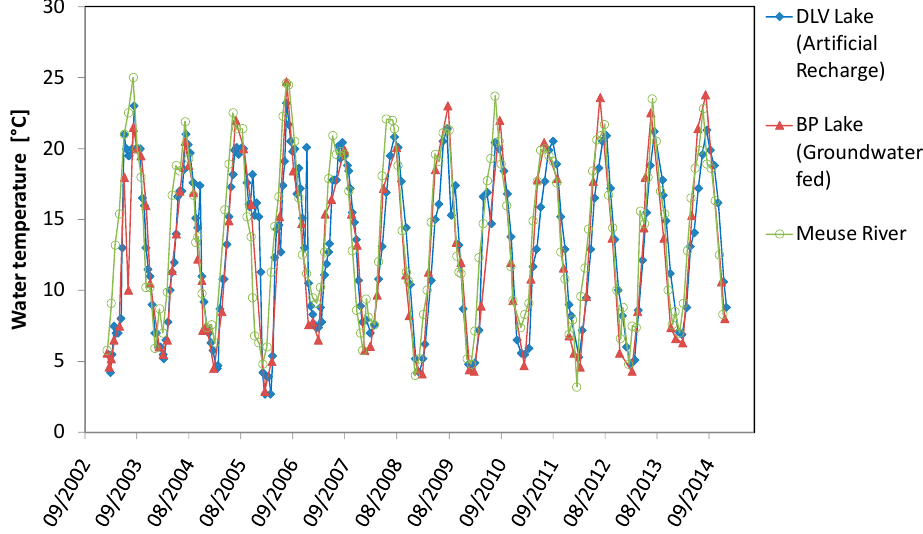
Figure 6. Temperature of gravel pit lake with artificial recharge (DLV Lake), groundwater fed only (BP Lake) and River Meuse water from 2002 to 2014.